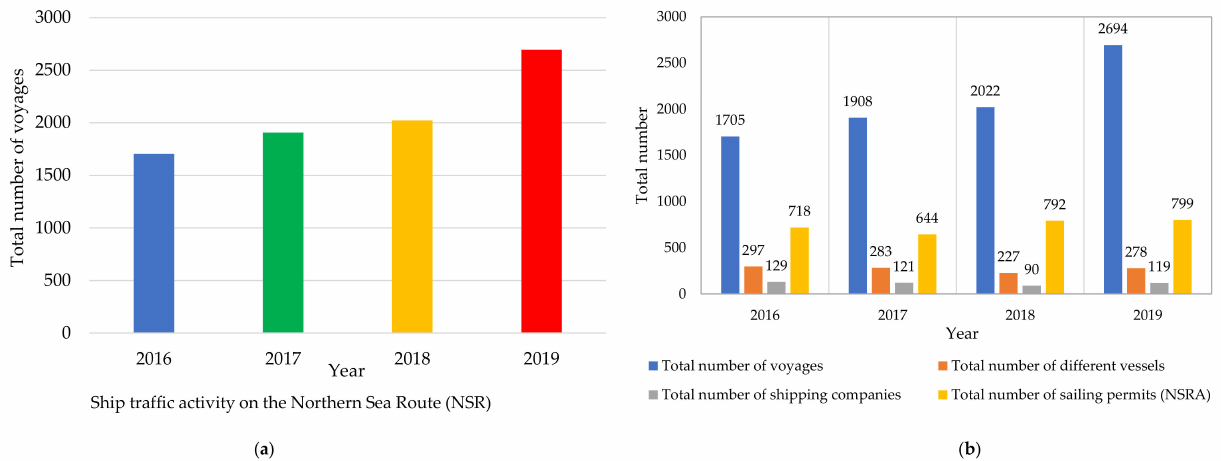
Figure 4. Ship traffic statistics on the Northern Sea Route (NSR) in 2016–2019: ( a ) the total number of voyages and ( b ) the total number of sailing permits for Russia’s Northern Sea Route Administration (NSRA) (redrawn based on data in Gunnarsson